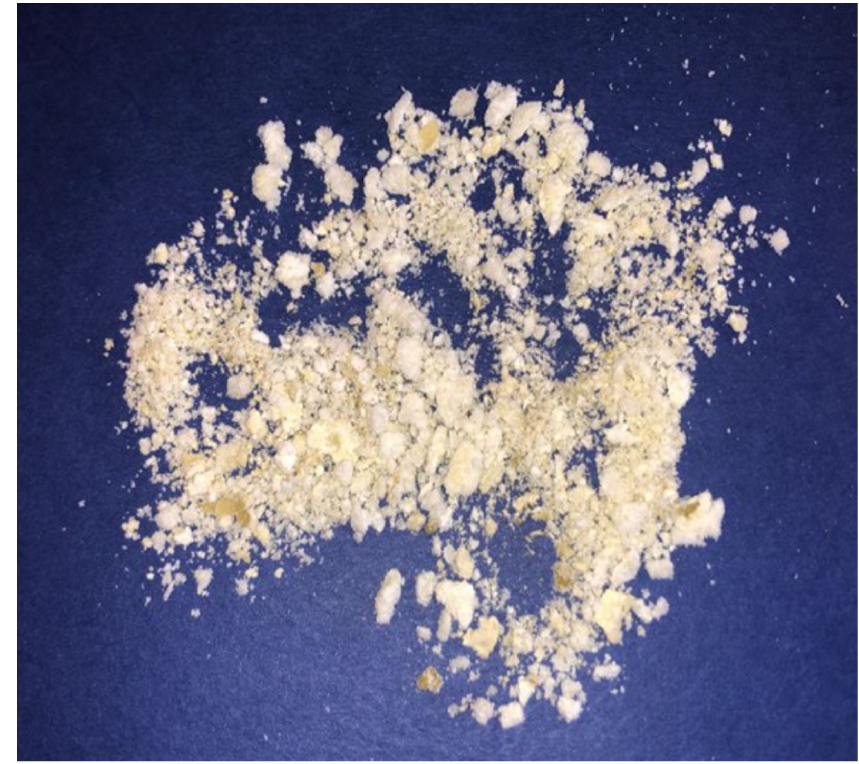
Figure 1. Macroscopic and qualitative example of cuticular waxes extracted by SFE processing of cannabis inflorescence.